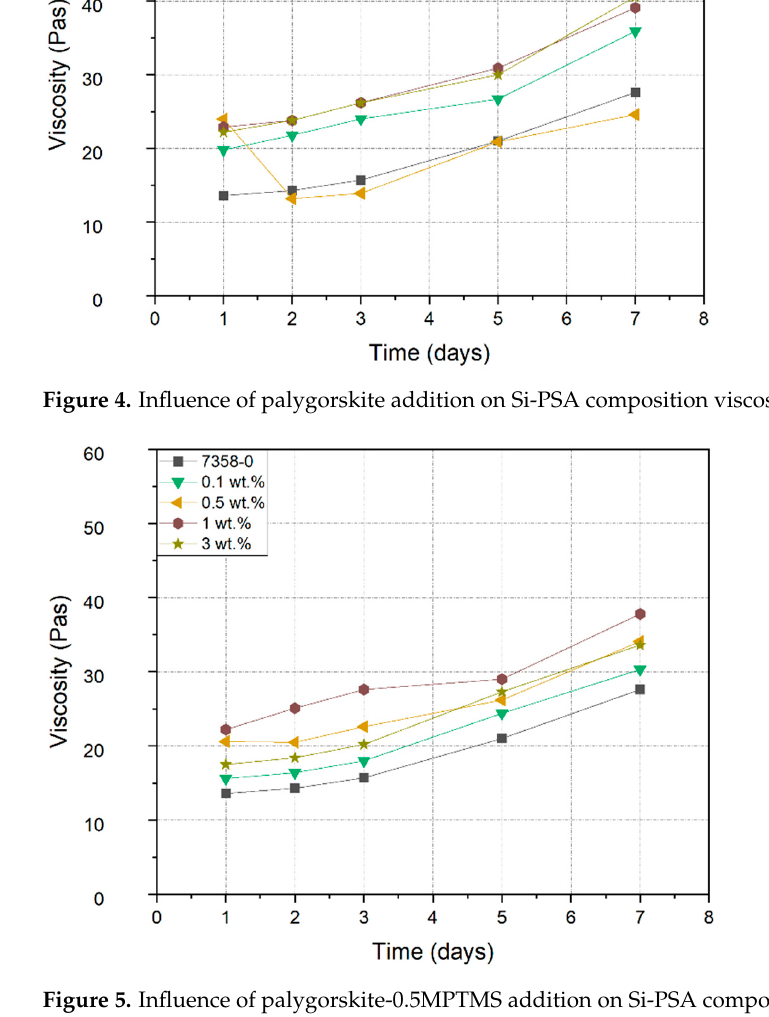
Figure 6. Influence of palygorskite-1.0MPTMS addition on Si-PSA composition viscosity. Figure 7. Influence of palygorskite-1.5MPTMS addition on Si-PSA composition viscosity.